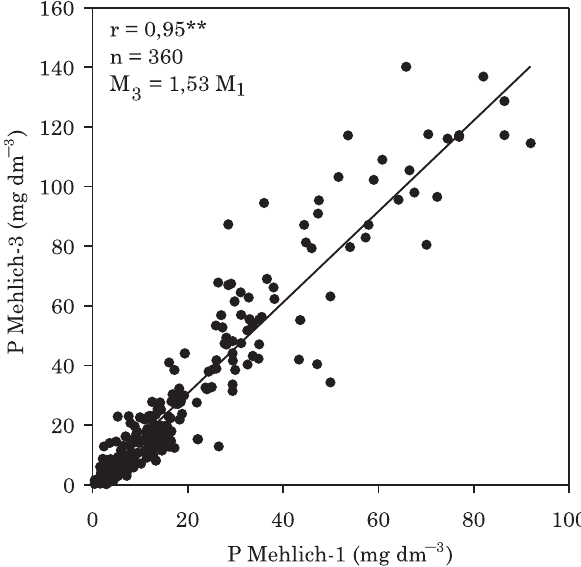
Figura 1. Correlação entre os teores de P extraído pelas soluções de Mehlich-1 e de Mehlich-3 em 360 amostras de solos do Rio Grande